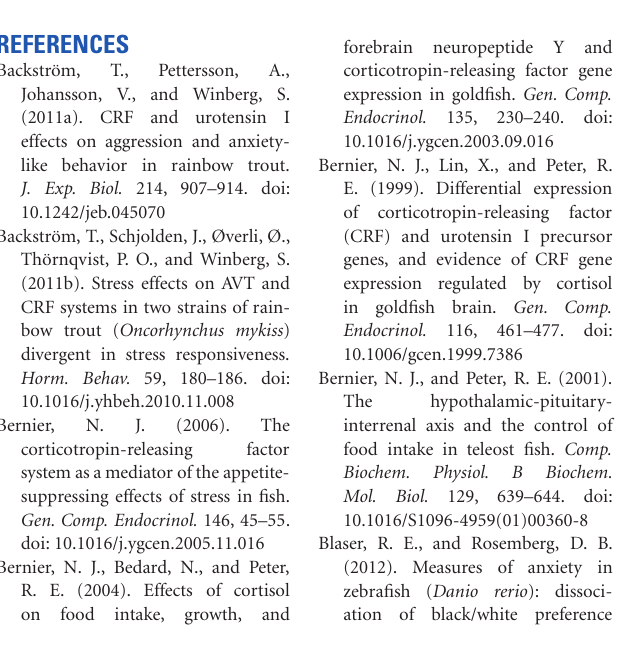
FG-7142 increases the time spent in the dark area, suggest- ing that the former and latter treatments induce anxiolytic- and anxiogenic-like actions, respectively (Matsuda et al.,